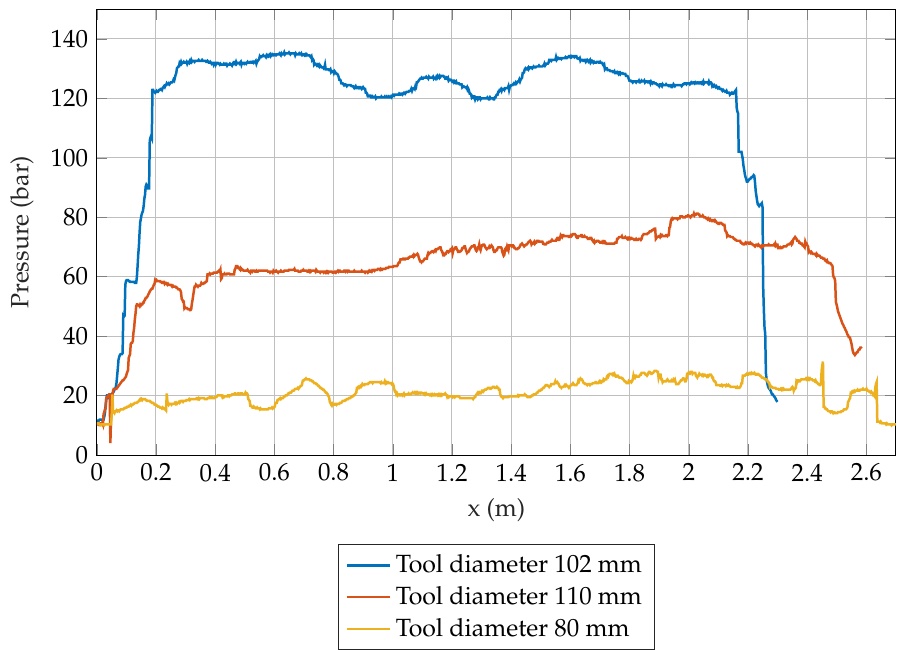
Figure 8. Pressure progressions when broaching tubes of three different diameters with three different